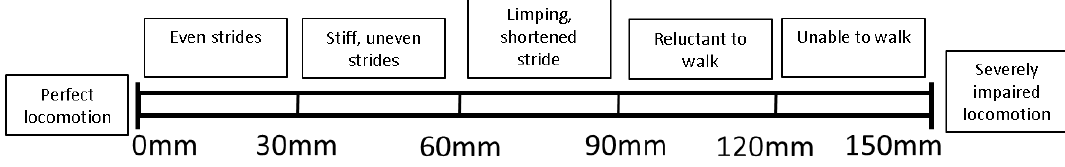
Figure 1. Example of a visual analogue scale for the scoring of overall locomotory ability developed for the purpose of this study.